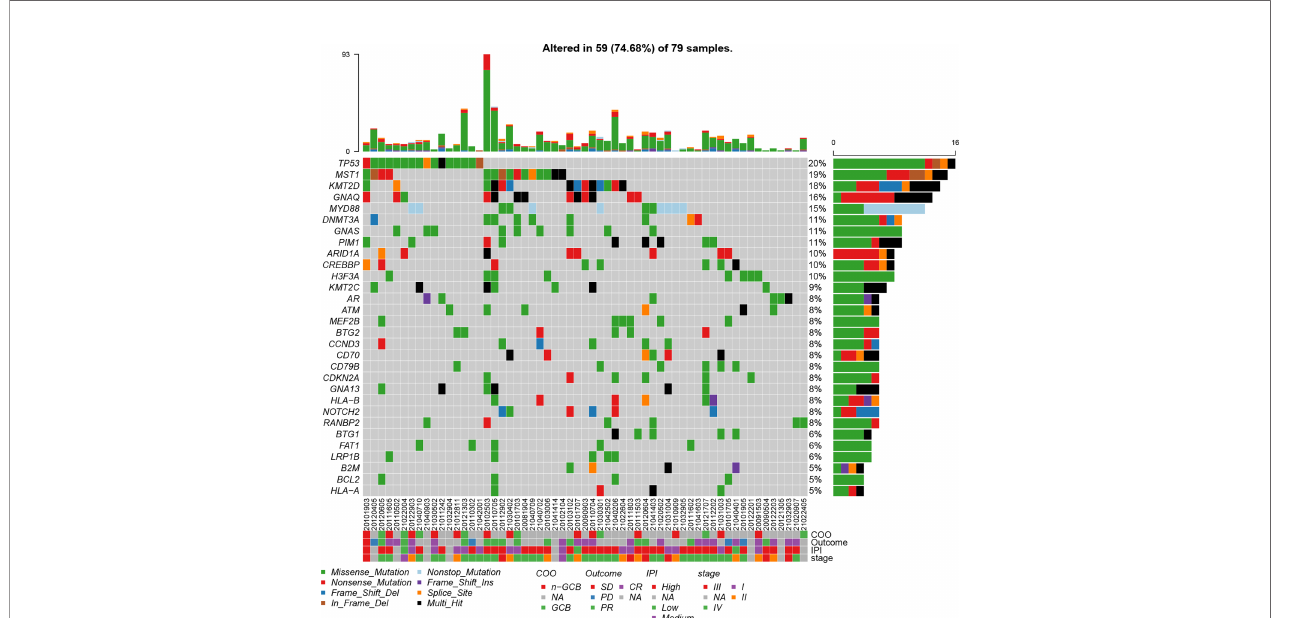
FIGURE 1 | Mutation plot showing top 30 frequently mutated genes in 79 B-cell lymphoma patients. Color-coded is indicated by type of mutation. Y axis shows the percentages of patients with at least one mutation in the speci fi ed